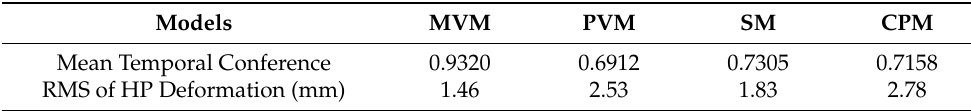
Figure 6. Average coherence map in slant range projection over green the rectangle area in Figure 2. Table 2. Quantitative comparison of accuracy for 4 models. Models